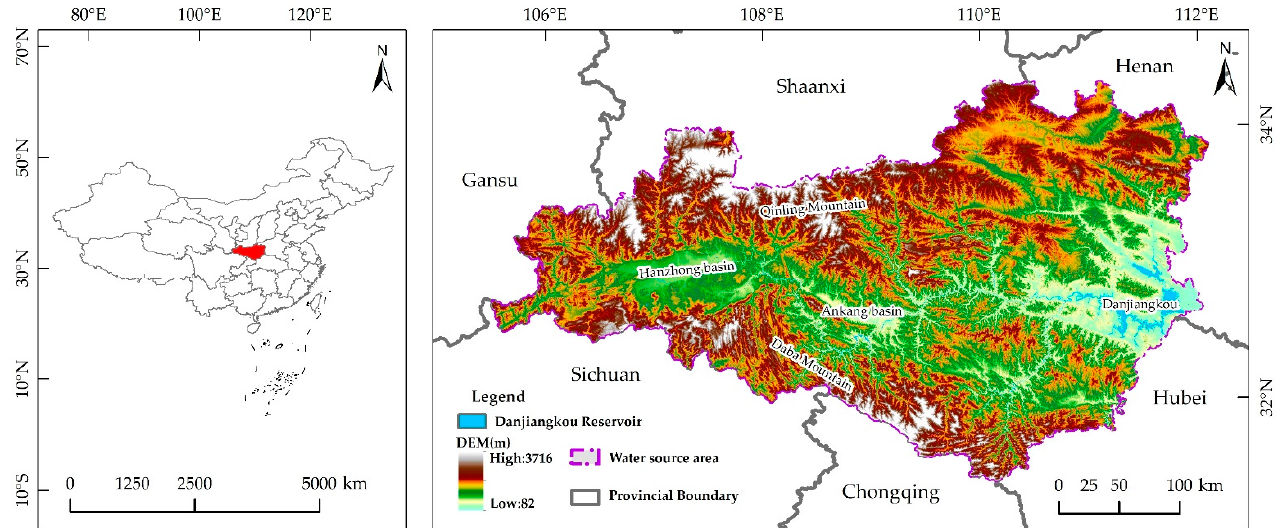
Figure 1. Sketch map of the water source area of the middle line of the South-to-North Water Diversion Project, China. The map is from the Chinese Standard Map (http://bzdt.ch.mnr.gov.cn/GS (accessed on 19 June 2022) (2019) 1822).